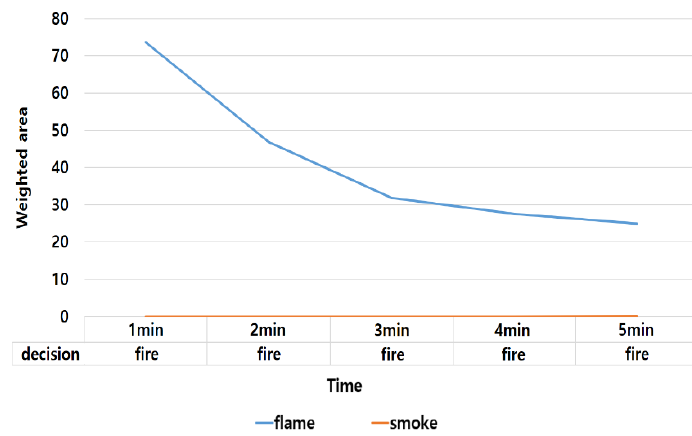
Figure 20. Changes in areas of flame and smoke with final decisions by majority voting for the video clip of Figure 19.